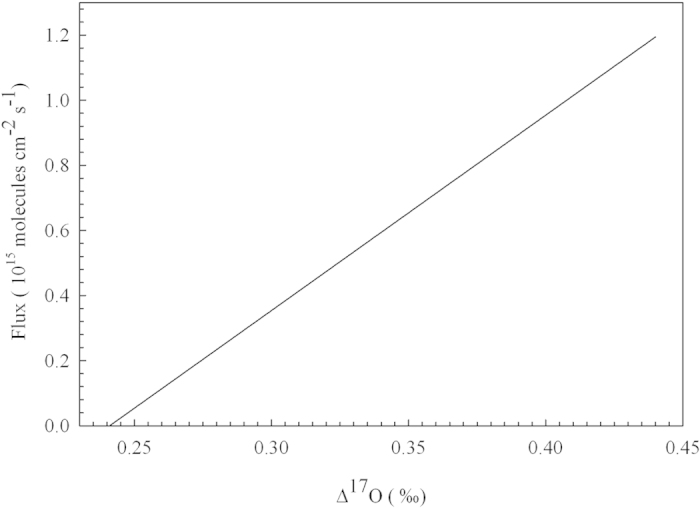
Inferred flux from the stratosphere obtained by assuming Fsur = 3 × 1015 molecules cm−2 s−1, Δ17Osur = 0.241‰, and Δ17Ostr - Δ17O = 0.5‰ (see text).